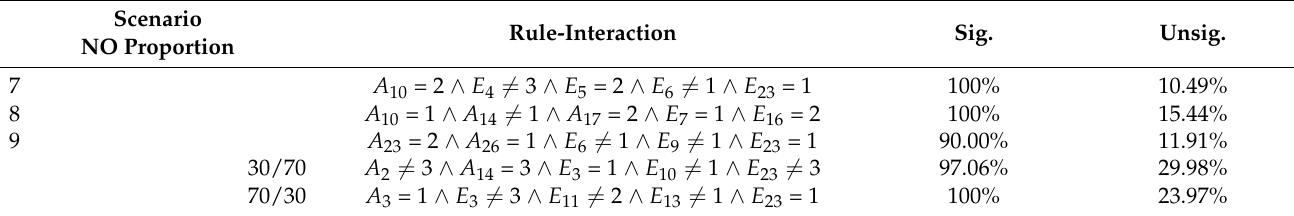
Table 5. Decision rules regarding work task